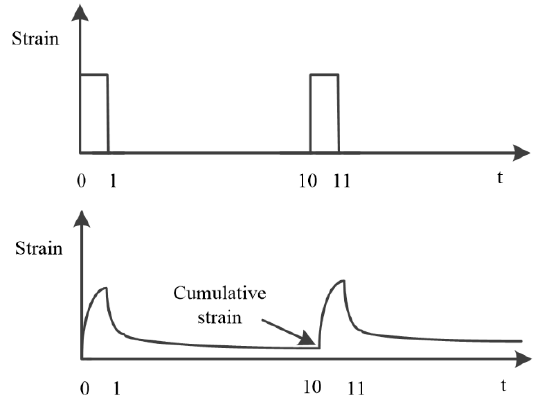
Figure 5. Loading pattern of repeated creep recovery test.